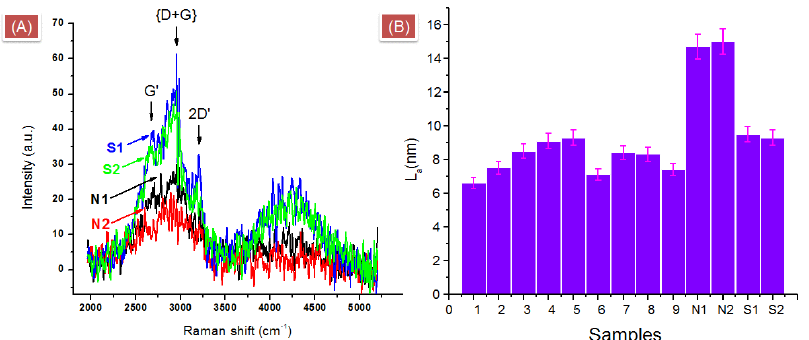
Figure A9. EDX spectrum of silicon-doped VOG (Sample S2) measured without Cu foil substrate.